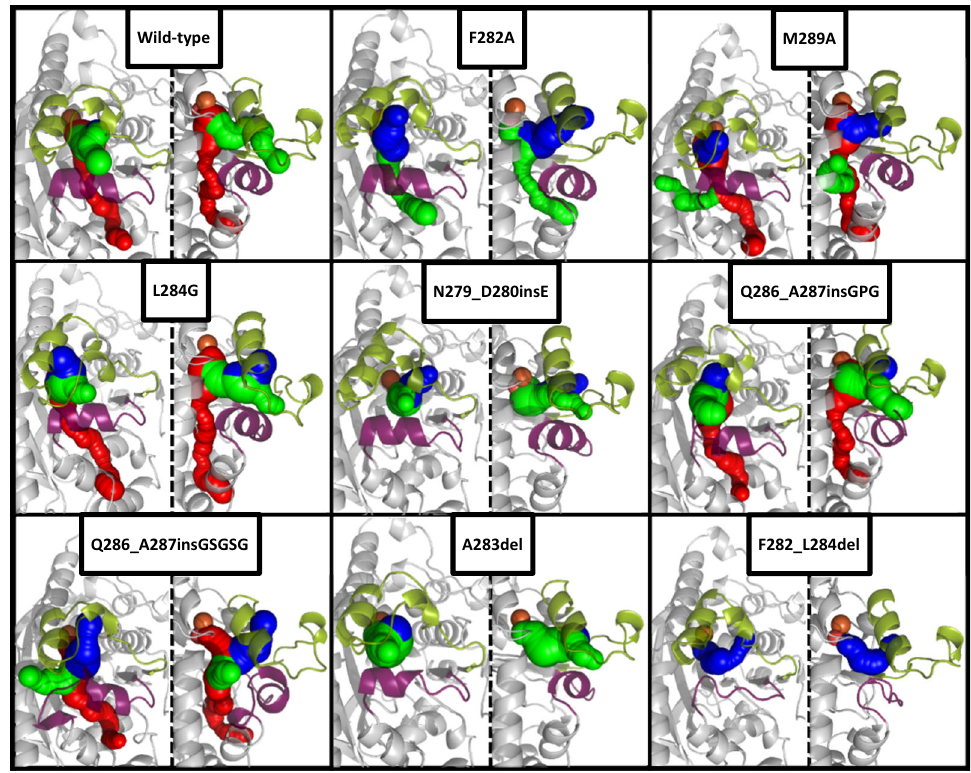
Fig. 6 CAVER analysis of the crystal structure-based homology models of the wild-type and selected loop variants from two different perspectives. The variants listed in Supplementary Table 9 were subject for homology modeling with subsequent MD re fi nement and 6 ps of MD simulations. The MD simulations were also performed on the crystal structure of the wild-type (PDB entry: 1WQL). The resulting energy minimized structures were analyzed with the CAVER plugin for PyMOL with a probe radius of 1.2 Å and iron as starting point. Loop 1 (green cartoon), loop 2 (purple), and the iron (orange sphere) are shown, as well as the resulting tunnels (tunnel 1 in blue, tunnel 2 in green, tunnel 3 in red).